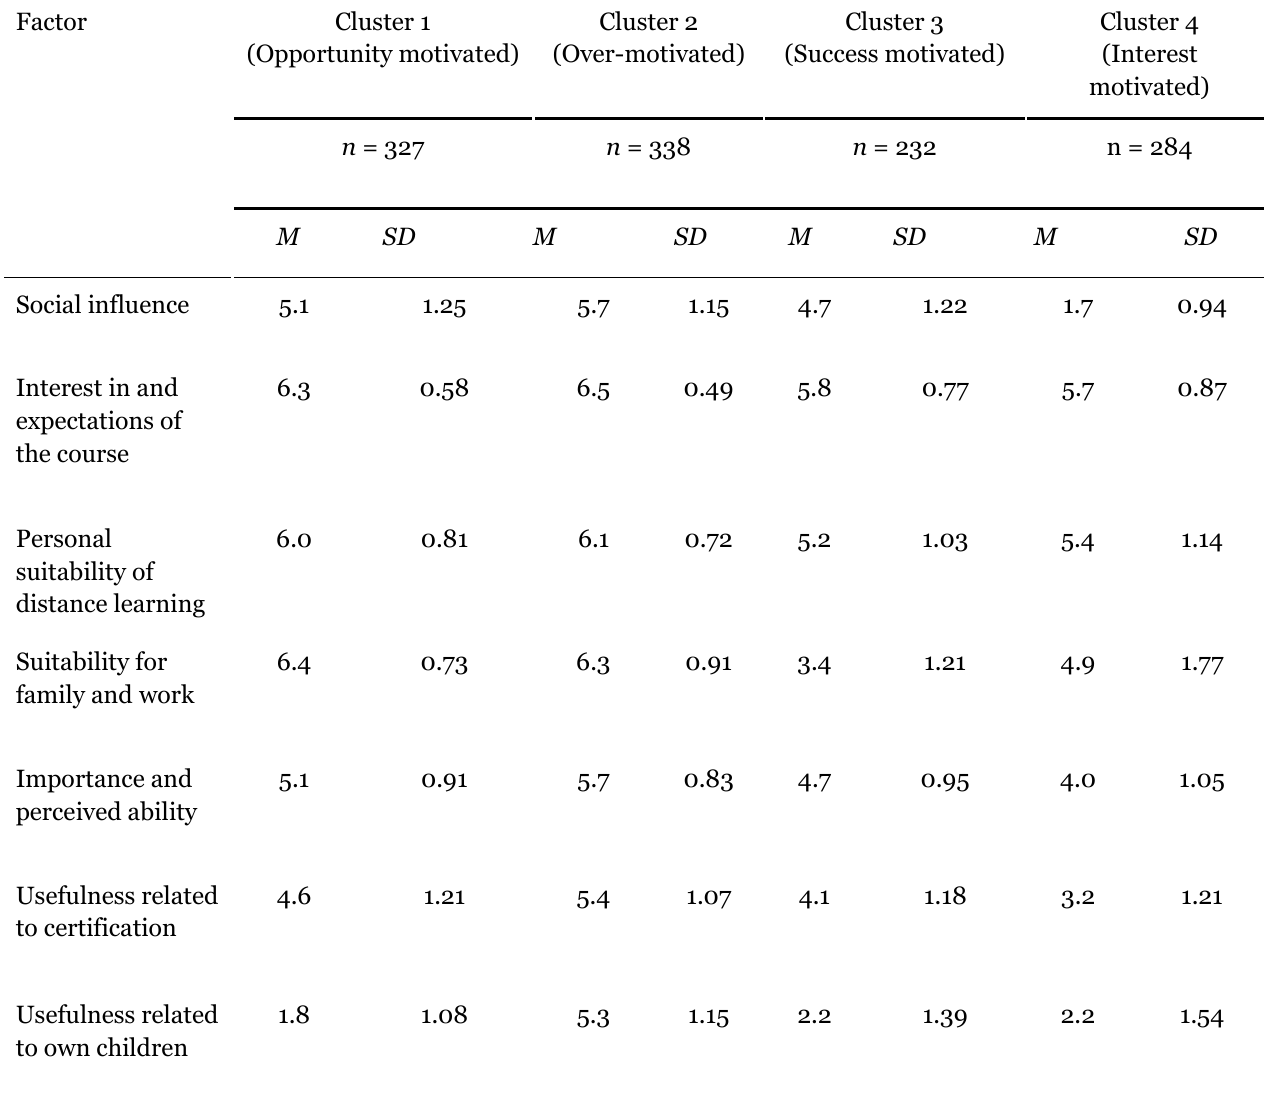
Descriptive Data of Motivation